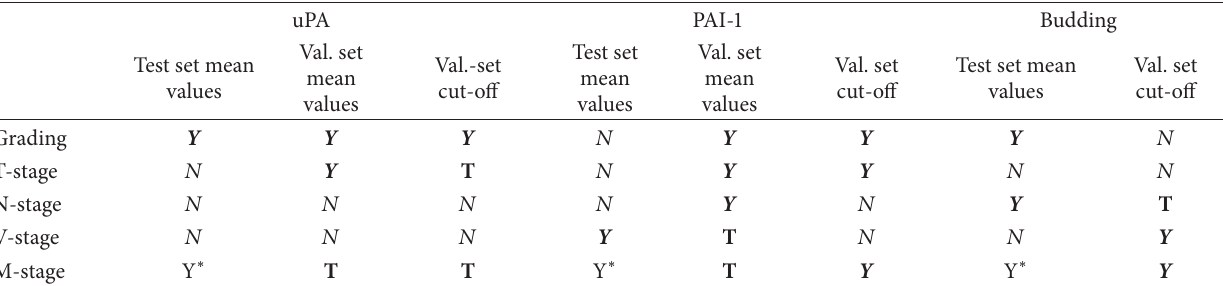
Table 3: Comparison of the results: test set versus validation set.